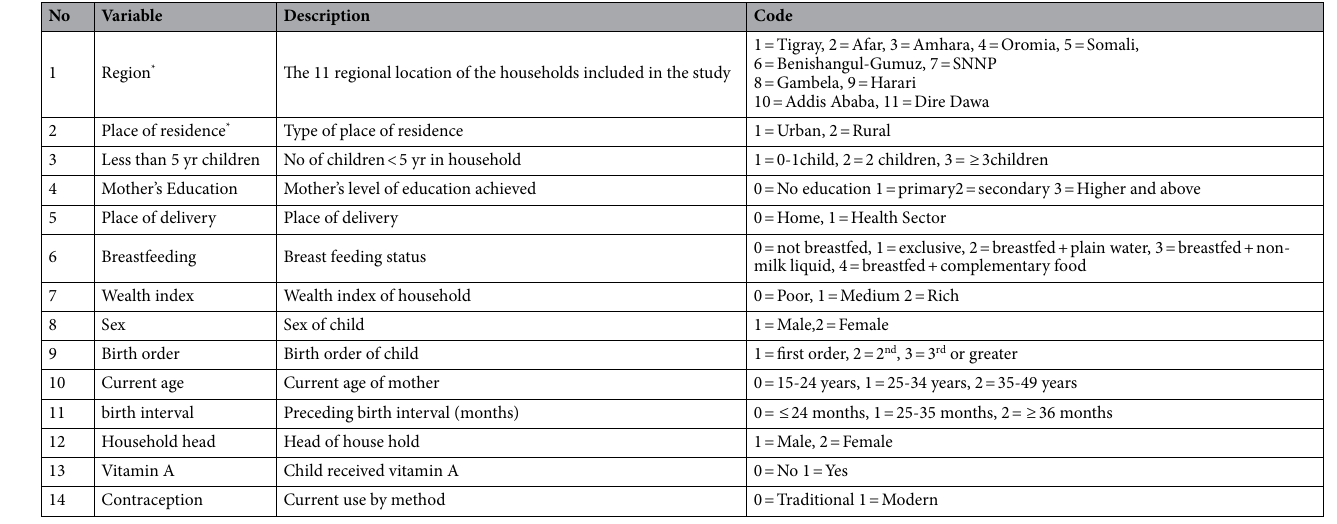
Table 1. Coding and description of explanatory variables. *community-level